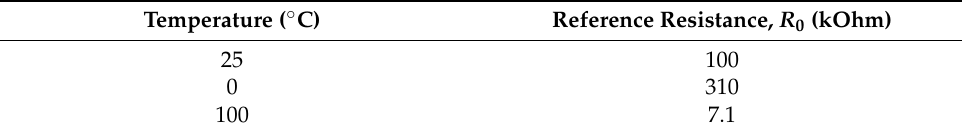
Table 3. Thermistor calibration measurements.